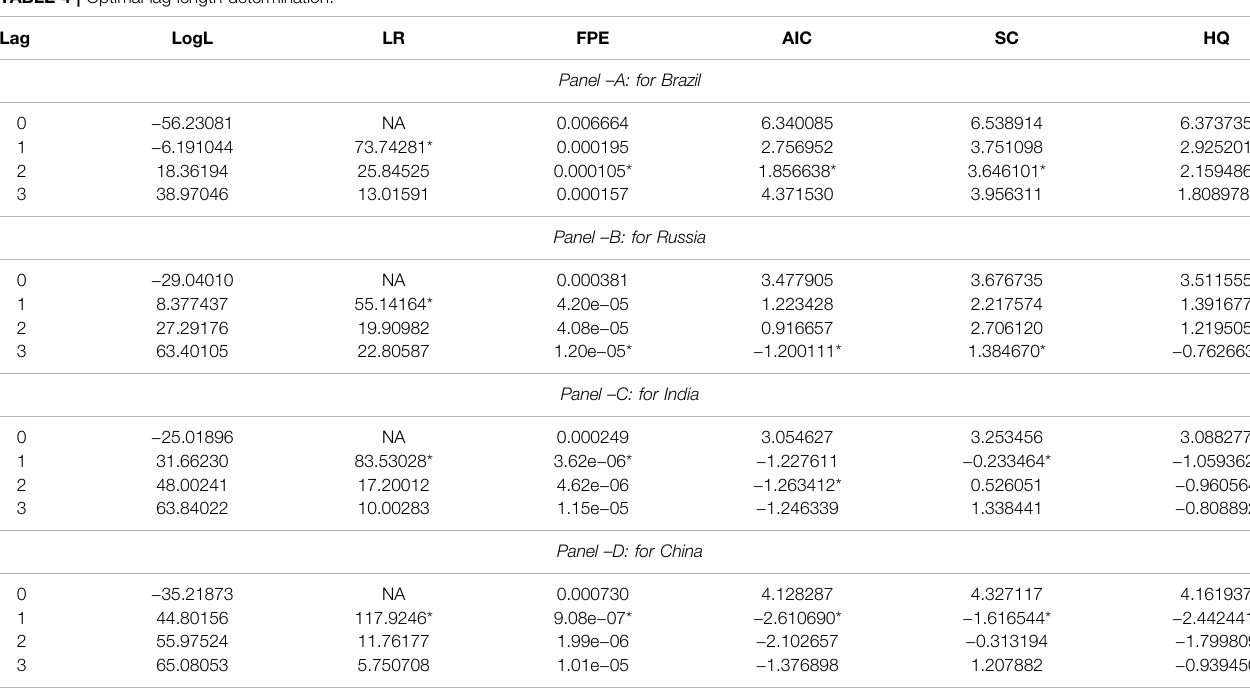
TABLE 4 | Optimal lag length determination.